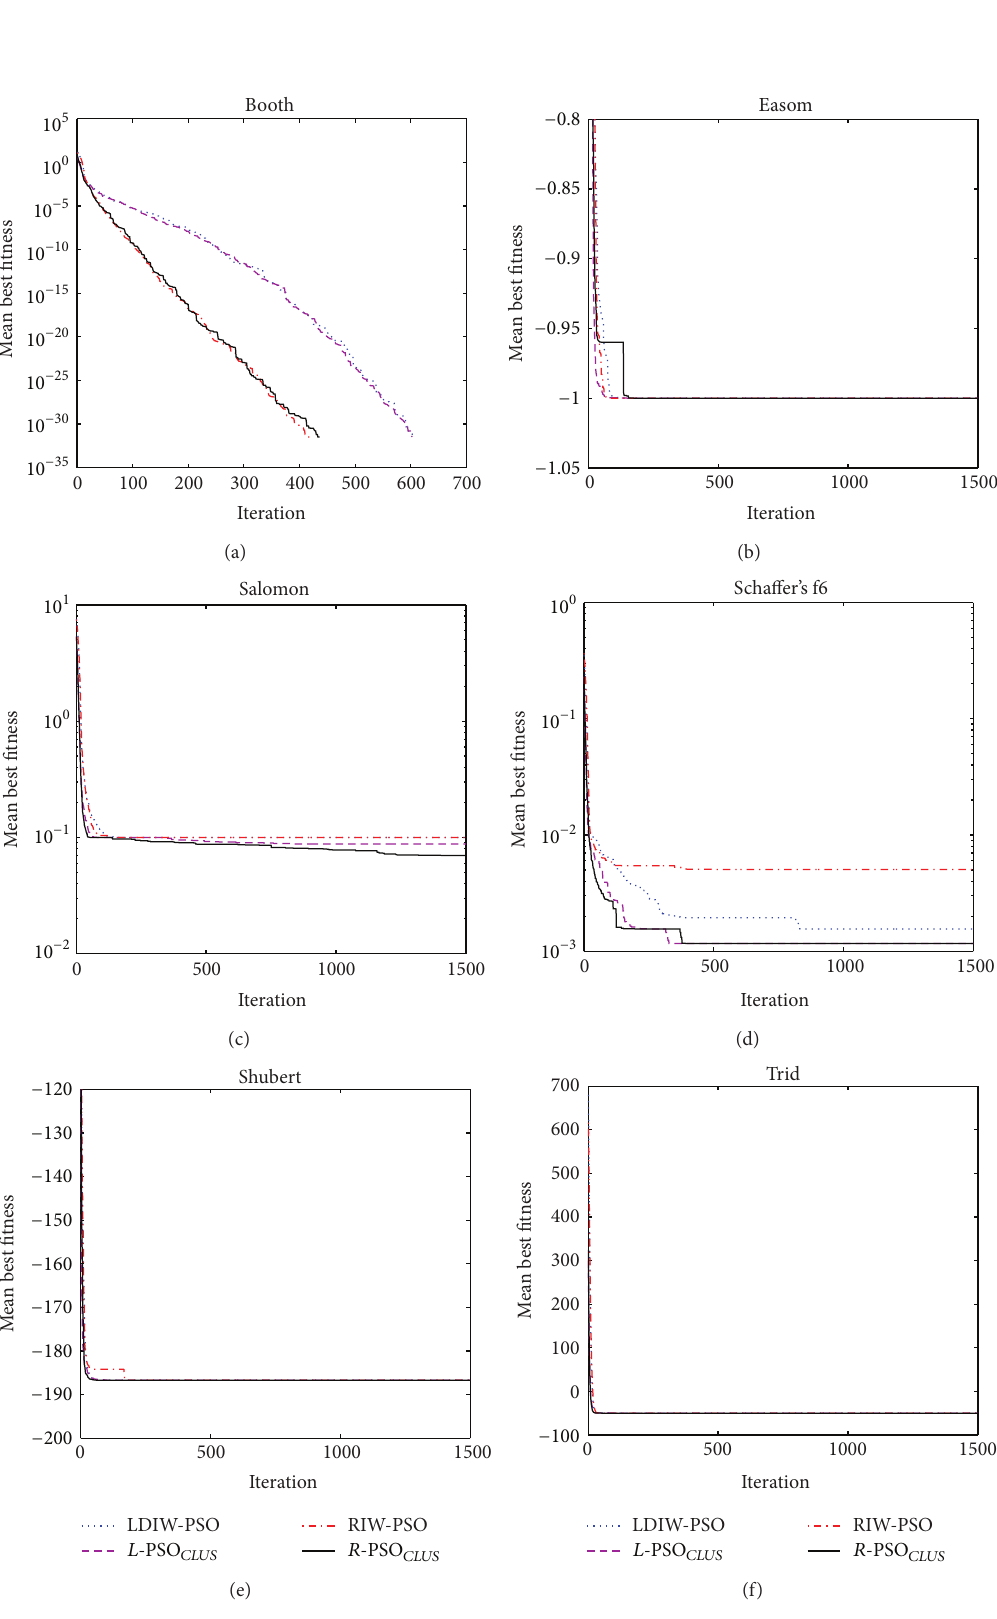
Figure 1: Convergence graphs for 6 of the nonscaled benchmark